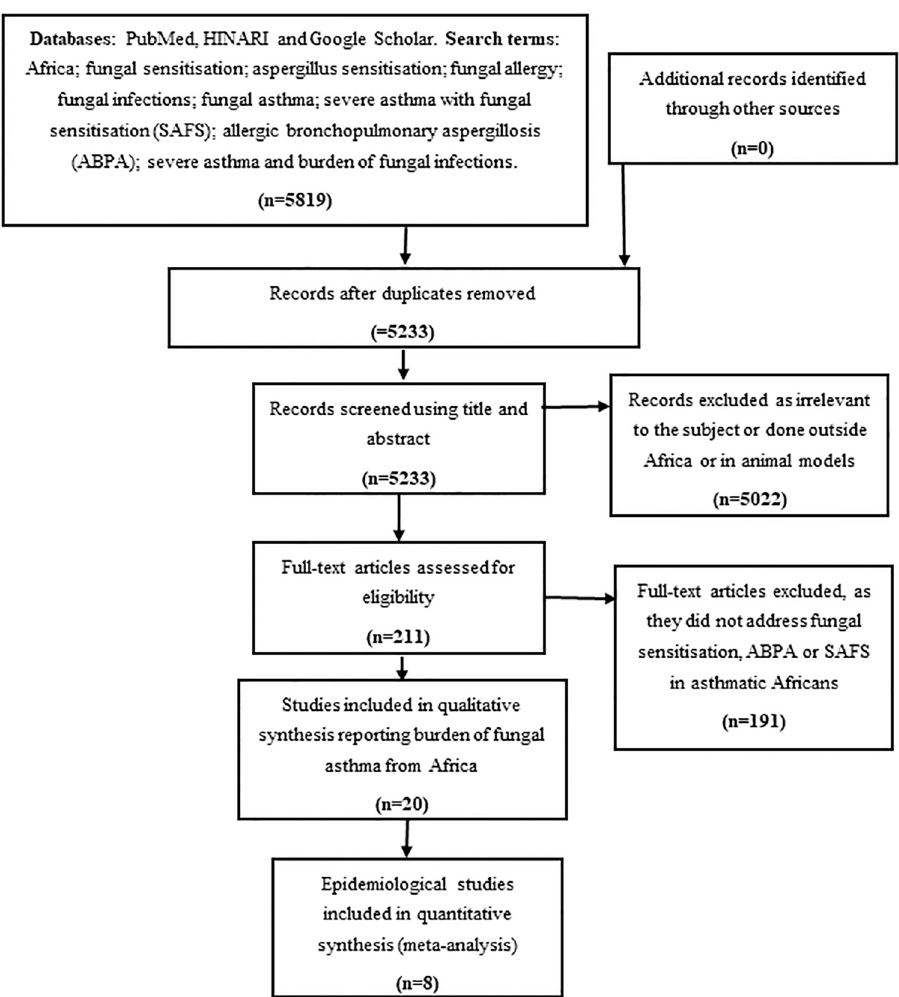
Fig 2. Citation selection process for the systematic review. Twenty studies were found describing the burden of fungal asthma in Africa. Eight were epidemiological studies and the twelve were review